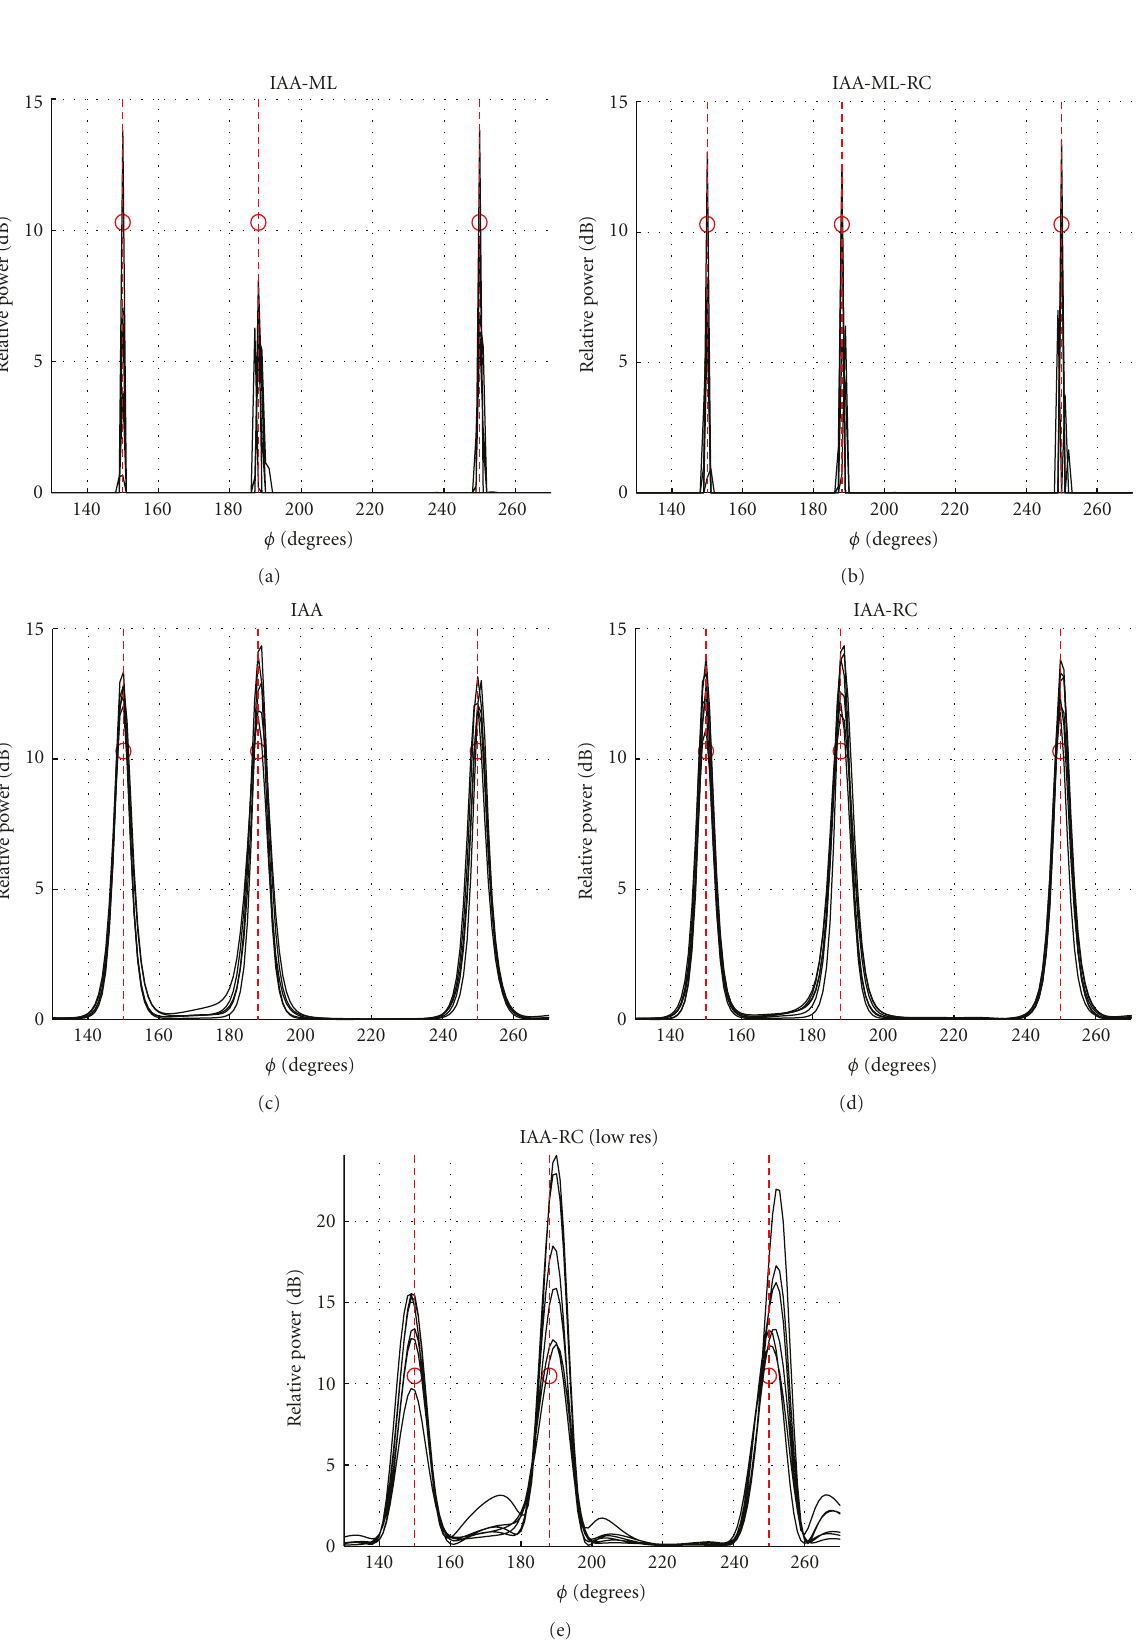
Figure 4: Spatial estimates of the di ff erent beamforming solutions (rectangular array, θ 1 = 45 ◦ , φ 1 = 150 ◦ , θ 2 = 45 ◦ , φ 2 = 188 ◦ , θ 3 = 45 ◦ , φ 3 = 250 ◦ , N = 3 snapshots, SNR 1 = SNR 2 = SNR 3 = 10dB, noise power equal to 0dB, and f c =